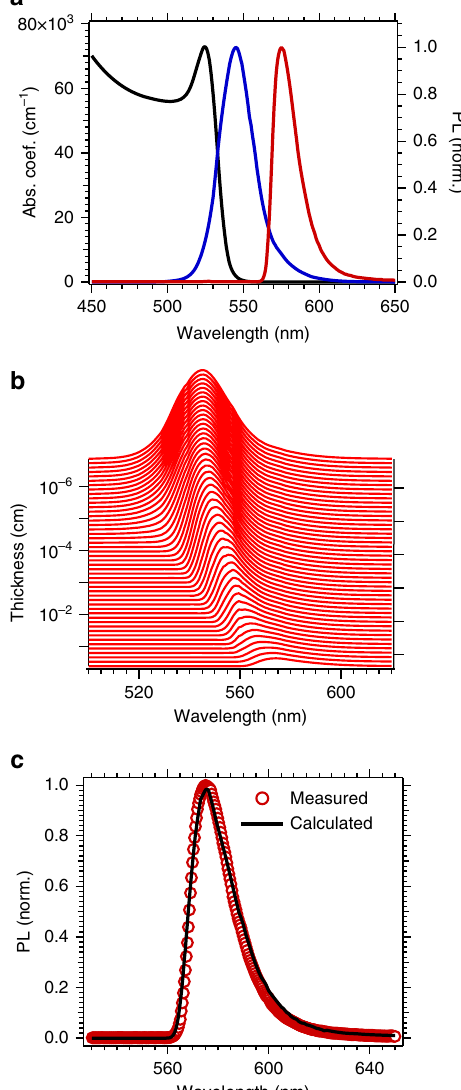
Fig. 2 Photoluminescence (PL) of single crystals of CH 3 NH 3 PbBr 3 .